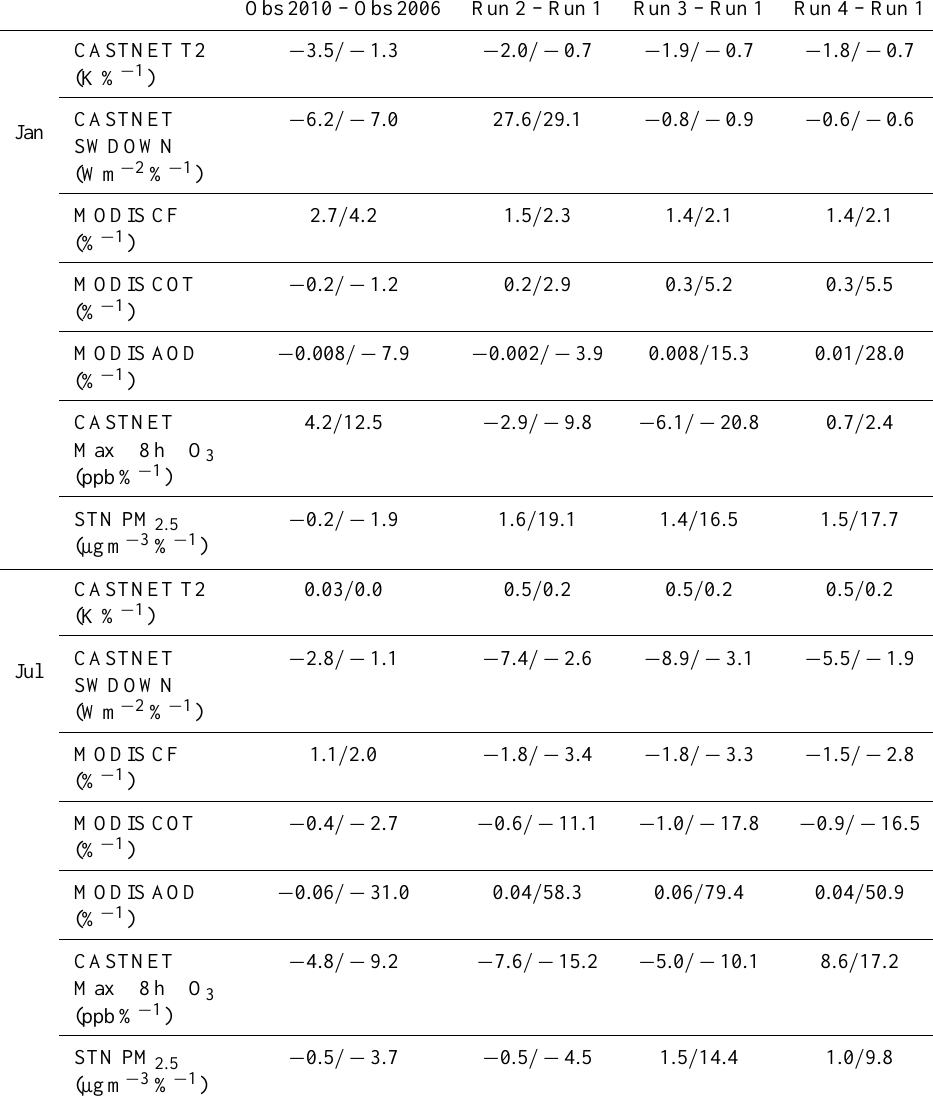
Table 4. Absolute and percentage differences between monthly mean of observed/satellite-retrieved data and sensitivity